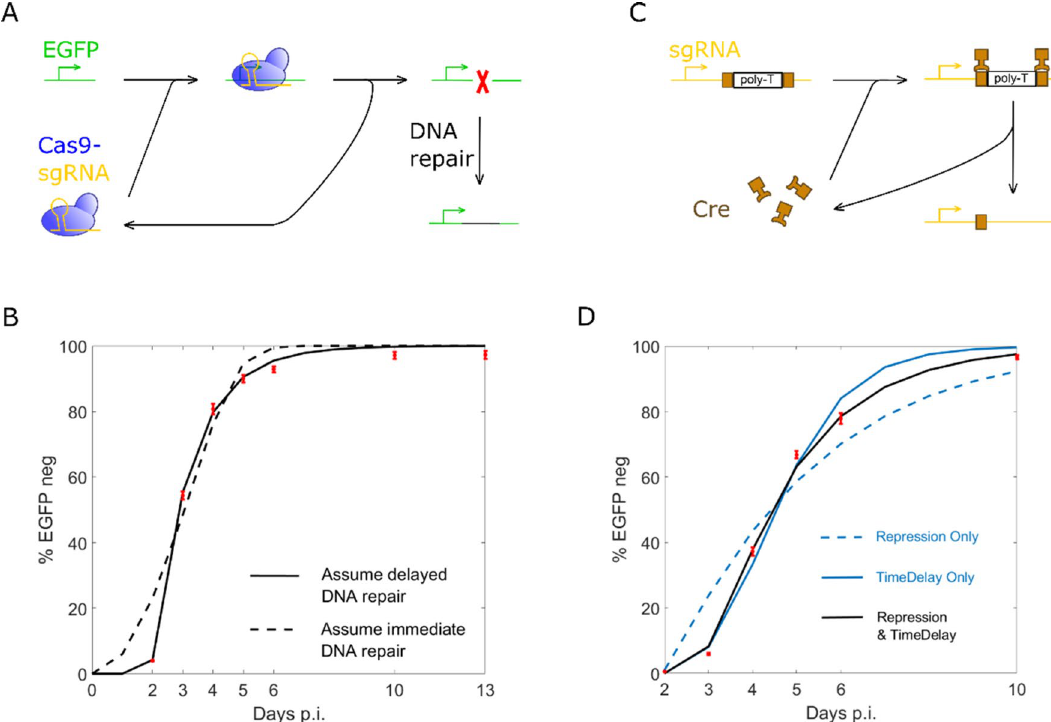
Figure 6. Intrinsic time delay in biomolecular activities. ( A ) DNA repair after CRISPR induced double strand break. ( B ) Data fitting for DNA repair with different assumptions. Model Assuming delayed DNA repair gives the best fit. ( C ) Cre recombination gives sgRNA transcription. ( D ) Data fitting for Cre activity with different assumptions. Both repression and time delay exist in Cre